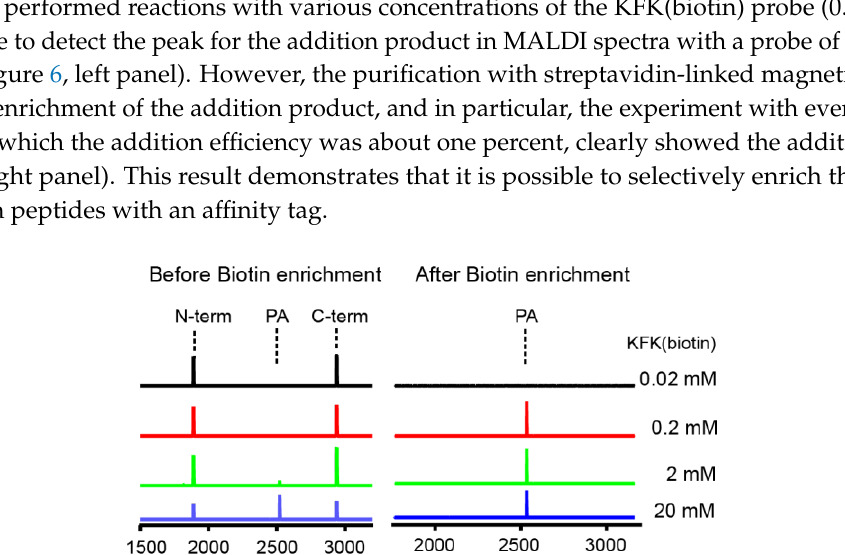
Figure 7. The probe addition products of the model protein substrates lysozyme ( A ) and MalE31 ( B ) were identified by MALDI-TOF-MS/MS. Misfolded lysozyme and MalE31 (80 µM each) were